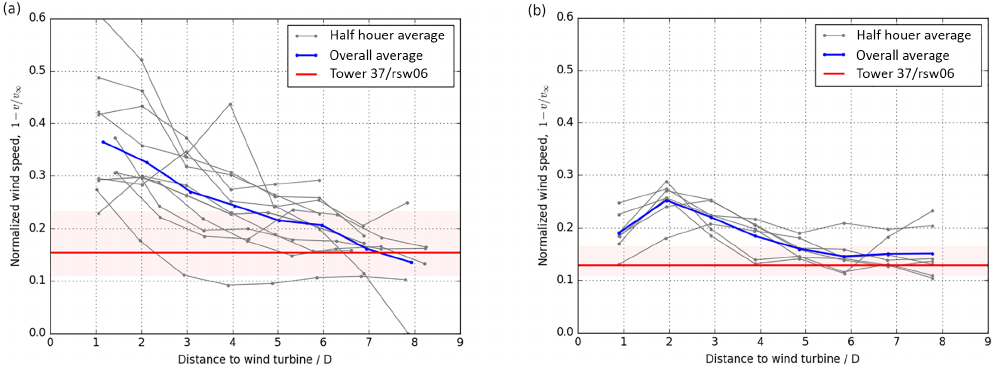
Figure 10. Turbulence intensity plotted against distance to the wind turbine for half-hour periods (gray lines) and overall average (blue line) on 17 May 2017 (a) and 2 June 2017 (b) . The red line shows the average turbulence intensity for the observed period on tower 37/rsw06, and the red area is the area between maximum and minimum turbulence intensity in the period.